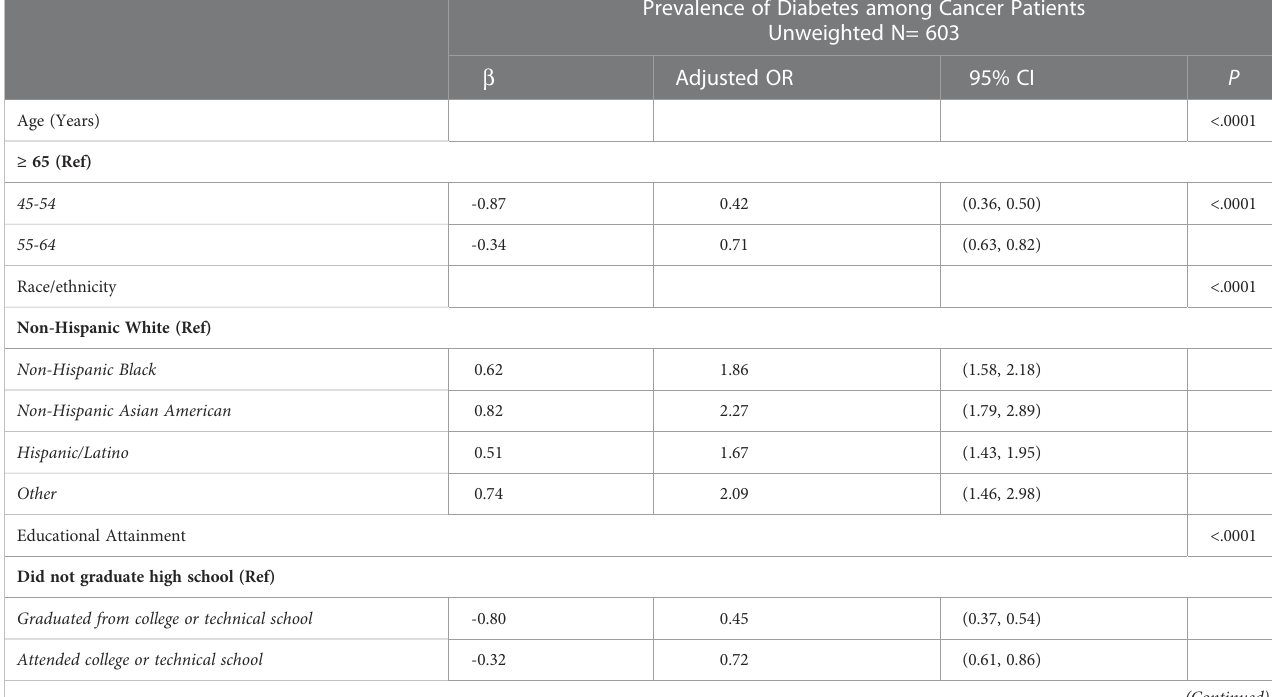
Prevalence of Diabetes among Cancer Patients Unweighted N=